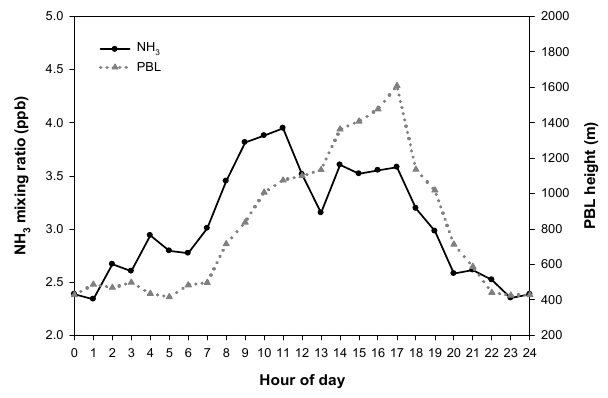
Fig. 9. NH 3 mixing ratios and PBL heights during the summer of 2010.